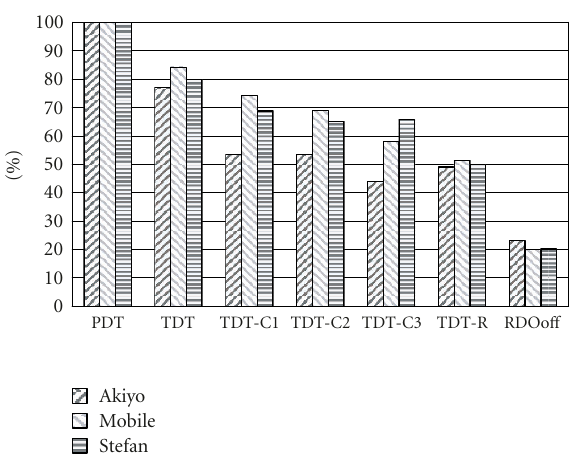
Figure 10: Complexity of proposed transcoders (%) relative to PDT. The threshold values used for Akiyo for TDT-C1, TDT-C2, TDT-C3 are 512, 1024 and 2048 respectively, and for mobile and Stefan, they are 12228, 16834, 24576, and 4096, 12228, 16384, re-